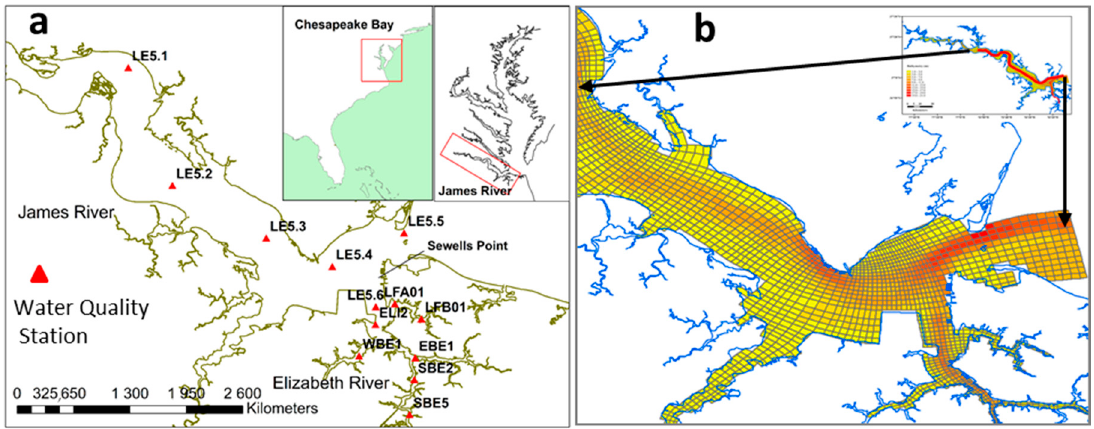
Figure 1. Location maps of James River and diagram of the numerical model grid. ( a ) area map with water quality monitoring stations (triangles are observation stations for DO verification), ( b ) model grid (the red line, insert figure denotes the area of channel deepening,).